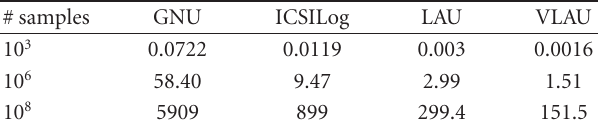
Table 7: Execution times (in ms) of GNU, ICSILog, LAU, and VLAU DP implementations for 10 3 to 10 8 invocations.